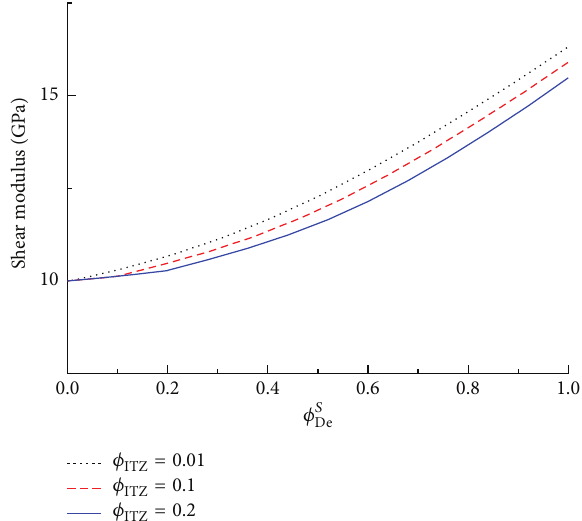
Figure 11: Influence of the ITZ on the shear modulus of repaired concrete during the healing process, where 𝜙 ITZ is the volume fraction of ITZ in the equivalent particle; 𝜙 𝑆 De is the volume fraction of the deposition products in the equivalent particle.